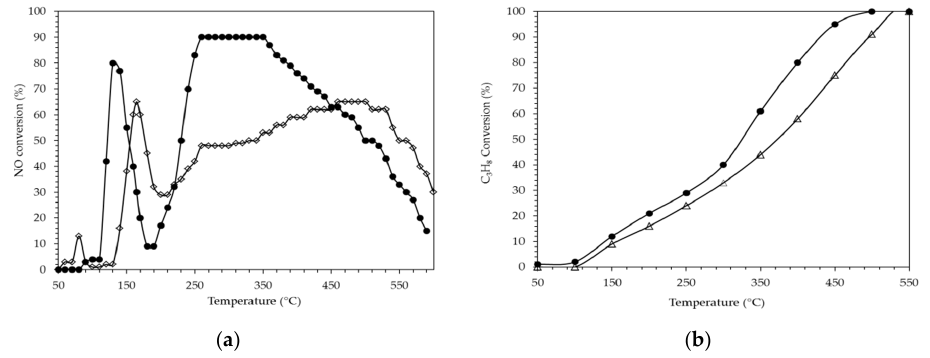
Figure 10. NO and C 3 H 8 conversion in the reaction C 3 H 8 –SCR–NO. ( a ) NO conversion with ( ● ) 0.1PtAg/AW and ( ◊ ) 2Ag/AW; ( b ) C 3 H 8 Conversion with ( ● ) 0.1PtAg/AW and ( Δ ) 2Ag/AW catalysts. Inlet gas composition: 500 ppm NO, 625 ppm C 3 H 8 , 200 ppm CO, 660 ppm H 2 , 2 vol.% O 2 , N 2 balance; GHSV = 128,000 h − 1